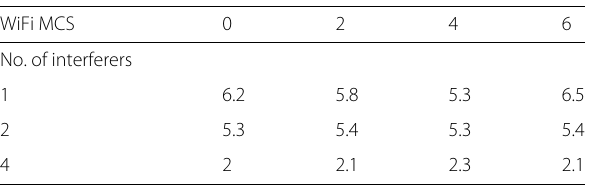
Table 2 SNR gain (dB) WiFi